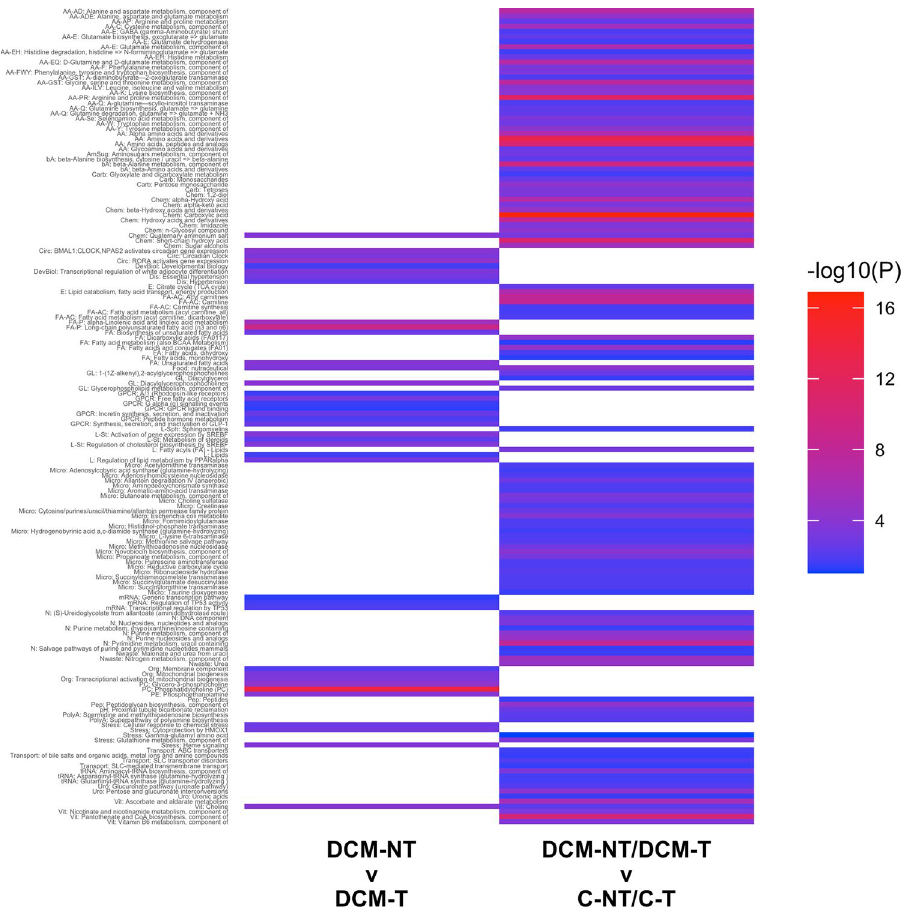
Figure 3. Tile plot showing pathway enrichments for the comparison of dogs by disease (dogs with DCM eating non-traditional diets [DCM-NT] + dogs with DCM eating traditional diets [DCM-T]) vs. (healthy controls eating non-traditional diets [C-NT] + healthy controls eating traditional diets [C-T]) and by diet (DCM-NT vs. DCM-T). Color reflects the corrected P value of enrichment, and white indicates the pathway was not significant in that comparison. The pathways that were enriched in the comparison by disease were almost completely different from the pathways enriched in the comparison by diet in dogs with DCM. Of 160 pathways, only three (choline, food nutraceutical, and quaternary ammonium salt) pathways were shared between these two